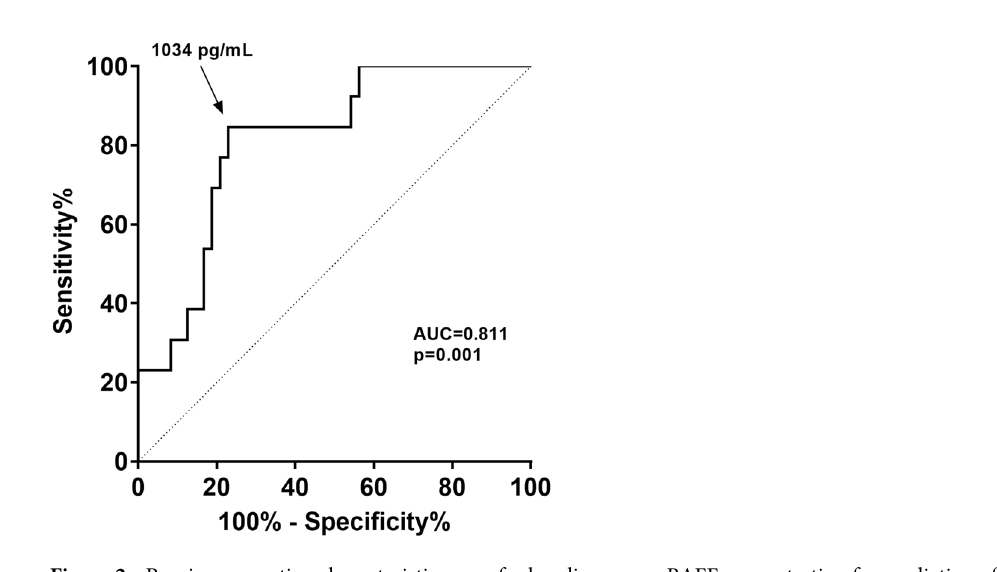
Figure 2. Receiver-operating characteristic curve for baseline serum BAFF concentration for prediction of the development of ADA at 6 m in patients older than 55 years. AUC Area Under the Curve. The serum BAFF concentration predictive cut-off (1034 pg/mL) was determined as the higher Youden index. p-value < 0.05 was considered statistically